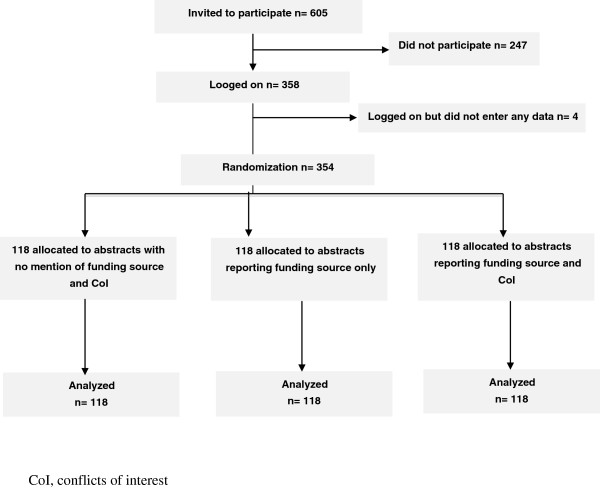
Flow diagram of general practitioner evaluators in the study.